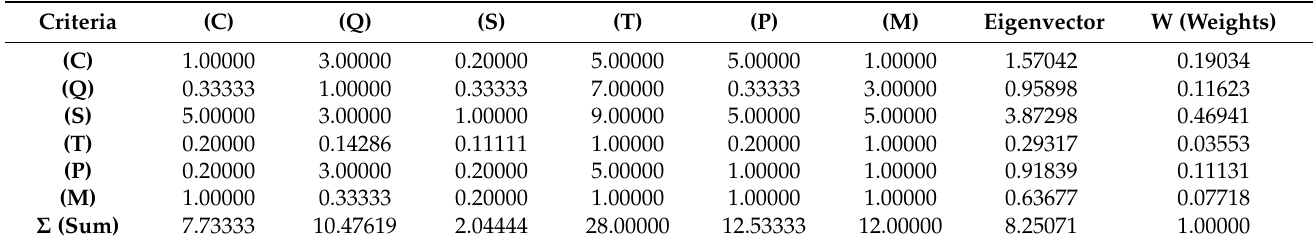
Table 13. Judgment matrix (full packaging